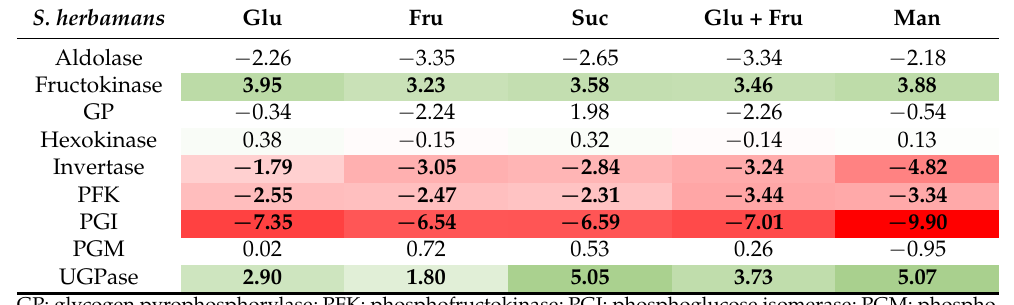
Table 4. Sugar regulation of extracellular enzyme activities of S. indica 5 days cultivated in the presence of glucose (Glu), fructose (Fru), sucrose (Suc), an equimolar mix of glucose and fructose (Glu + Fru), mannose (Man) or without sugar. The table shows the M-values (log2 of ratios of values obtained from sugar-treated cultures to values from cultures cultivated without sugar). Values higher than 1 (>2-fold induced) below − 1 (>2-fold repressed) and which are based on significant differences (Tukey HSD test; n = 6) are indicated in bold and color-coded (green: sugar induction; red: sugar repression). Activities of UDP-glucose pyrophosphorylase were not detected.